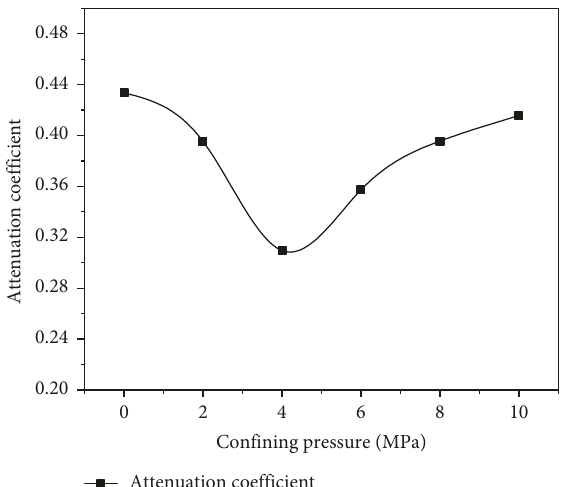
Figure 9: Variation law of the physical attenuation coefficient under different confining